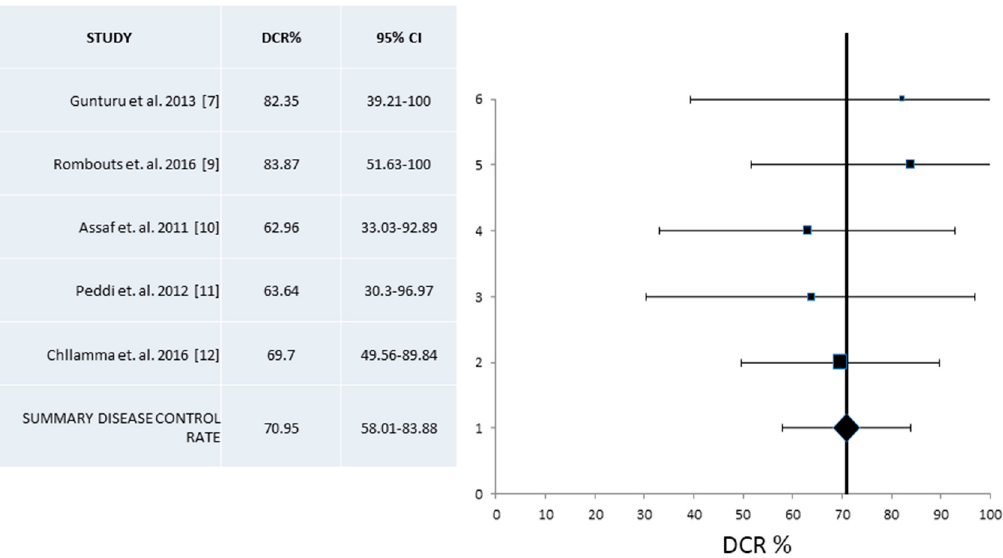
Figure 3. Pooled analysis of Disease Control Rates (DCR) and 95% Confidence Intervals (CI) from published series. Five studies with a total of 163 patients that provided information for the DCR were included. Overall, DCR was 70.95% (95% CI 58.0–83.9%).